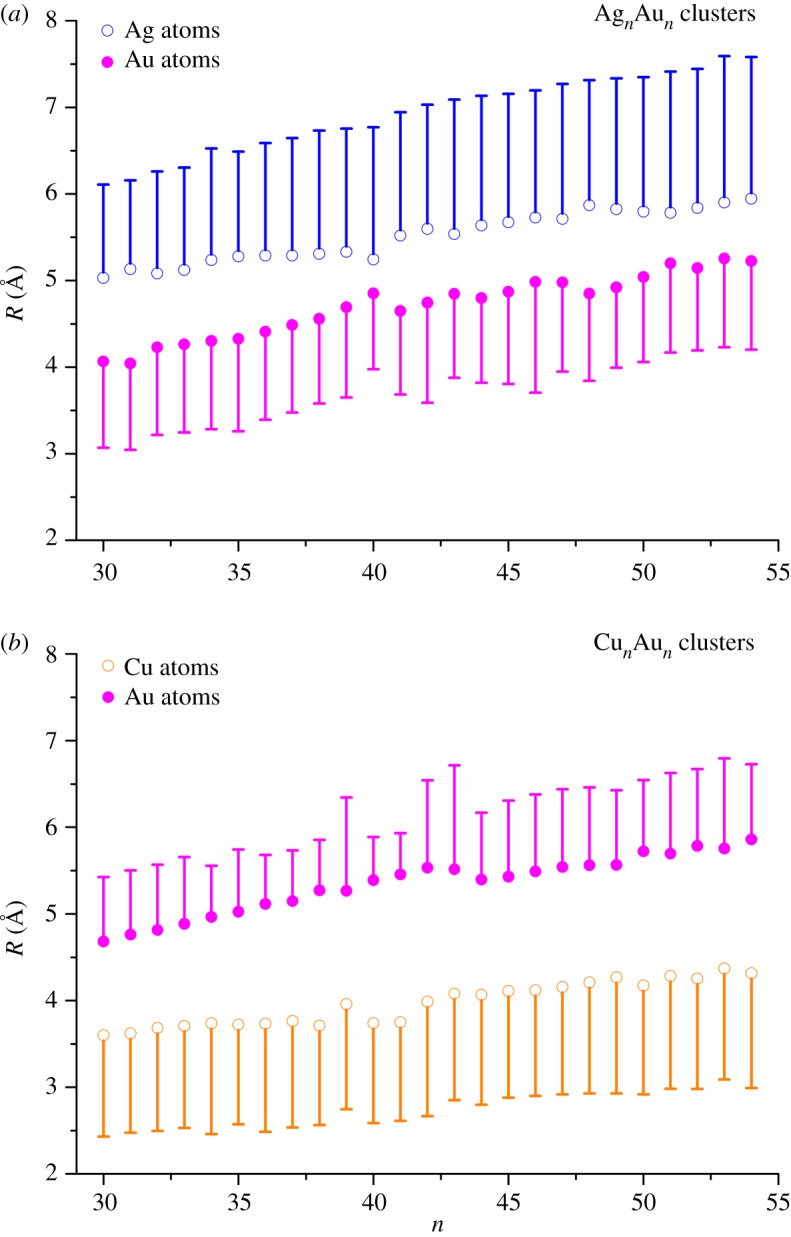
Average distance (R) of Ag and Au atoms from the centre of AgnAun cluster (a) and Cu and Au atoms from the centre of CunAun cluster (b) with the standard deviation. Error bars show the standard deviation. For clarity, only half the error bar is shown.